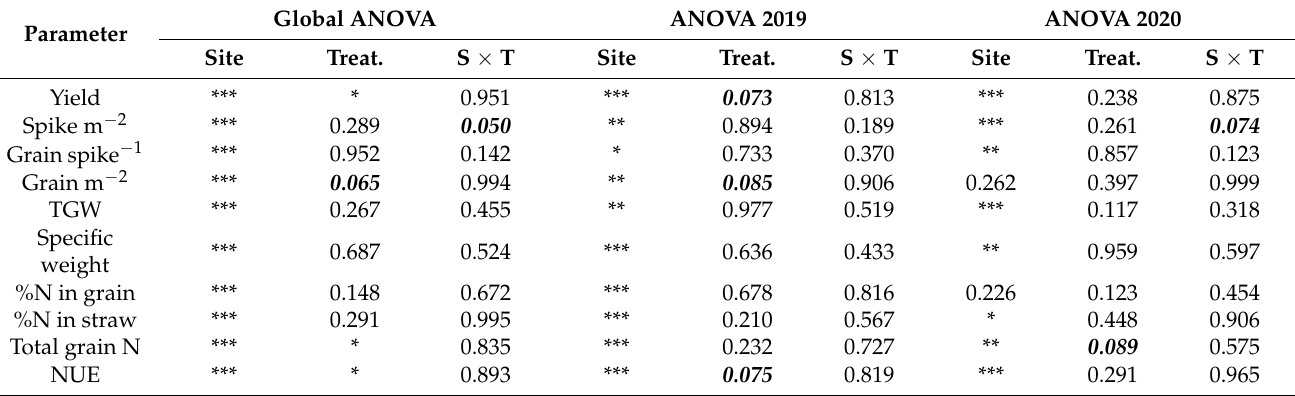
Table 2. Effects of site (S) and/or biostimulant treatment (T: VNT4) on grain yield, yield components and N-related traits determined by two-way ANOVA (global ANOVA and for each year).